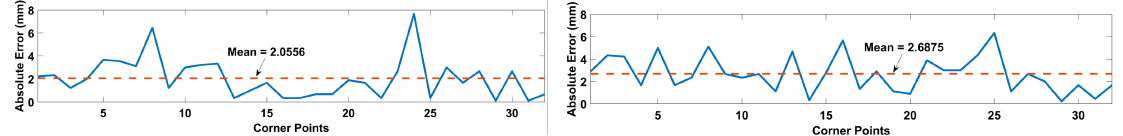
Figure 10. Absolute errors at 32 corner points of the wing for ( Left ) 2.45 N load. ( Right ) 14.71 N load.